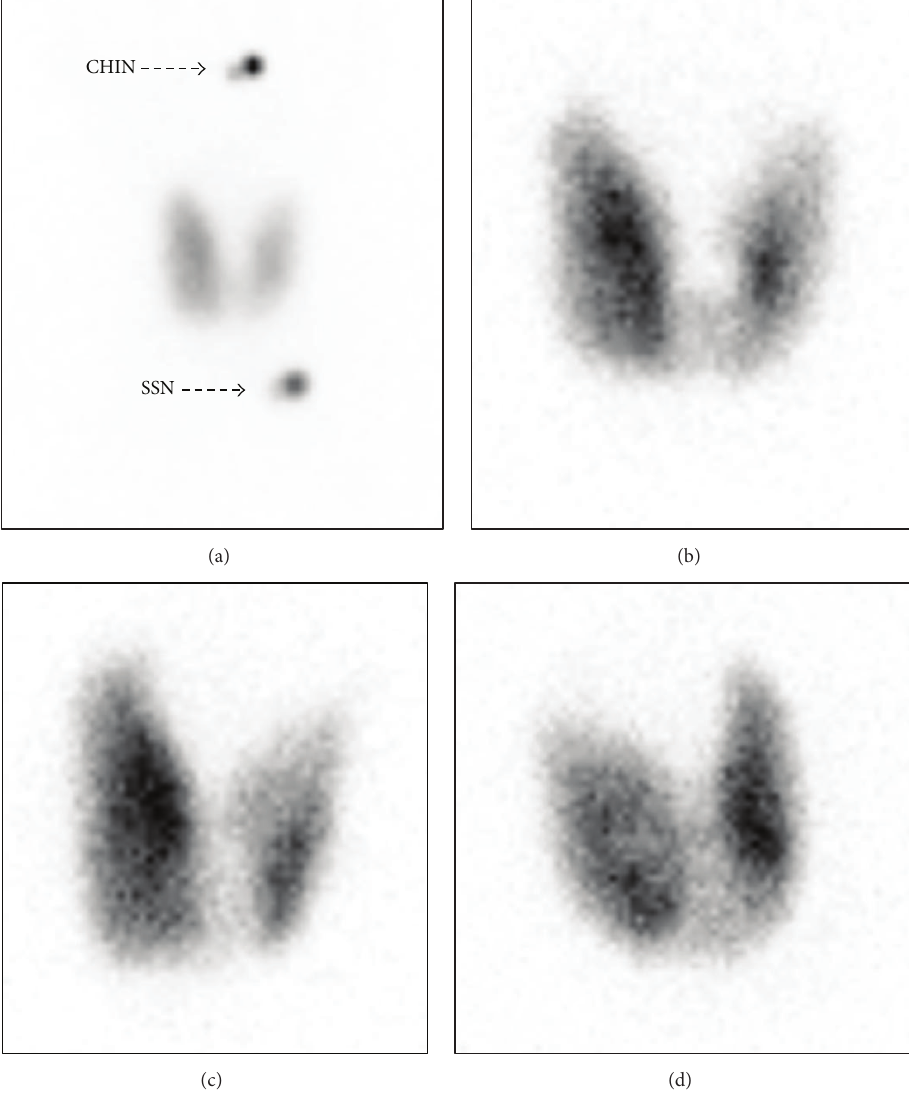
Figure 1: Twenty-four-hour radioactive iodine-123 uptake test. The images show diffuse uptake of 45% in the anterior view at high resolution with markers (a), anterior view with the pinhole collimator (b), right anterior oblique view with the pinhole collimator (c), and left anterior oblique view with the pinhole collimator (d). SSN: substernal